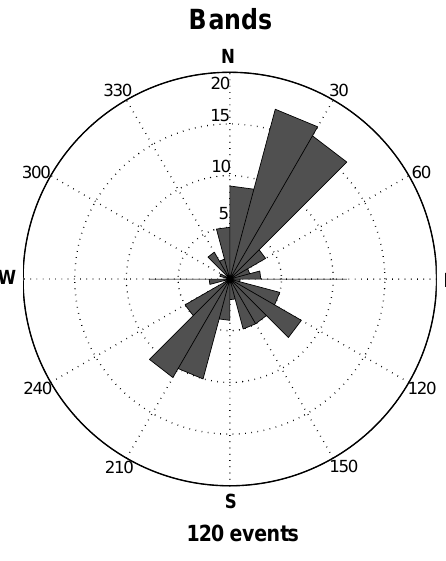
Fig. 6. Polar histogram of the propagation directions for all bands. The values in radial direction represent the number of wave propa- gation in each